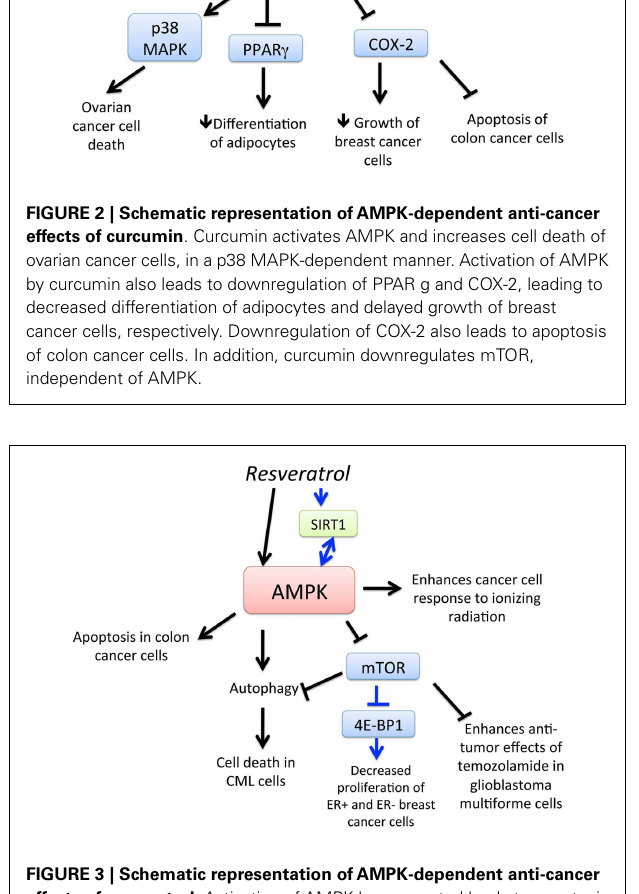
FIGURE 3 | Schematic representation ofAMPK-dependent anti-cancer effects of resveratrol . Activation of AMPK by resveratrol leads to apoptosis of colon cancer cells, enhancement of cancer cell response to ionizing radiation, and mTOR-dependent and – independent autophagy, leading to cell death in chronic myelogenous leukemia (CML) cells. Resveratrol also activates SIRT1, which leads to AMPK activation, leading to downregulation of mTOR and inhibition of 4E-BP1 and decreased proliferation of estrogen receptor-positive (ER + ) and ER-negative breast cancer cells. Furthermore, activation of AMPK and subsequent downregulation of mTOR increases sensitivity of glioblastoma multiforme (GBM) cells to temozolomide.